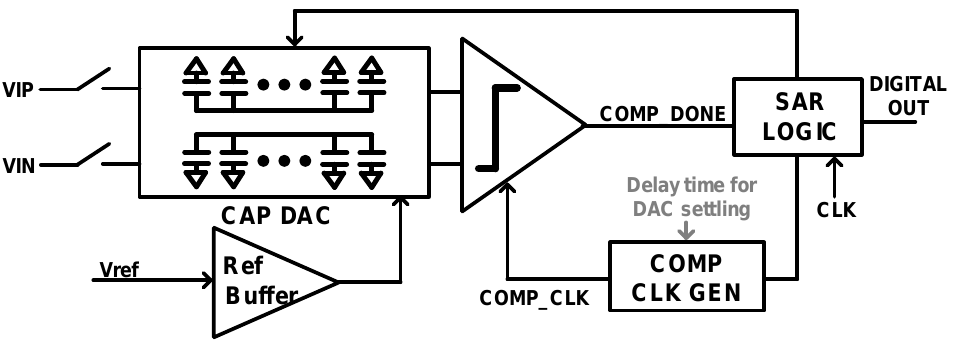
Figure 1. Structure of asynchronous SAR